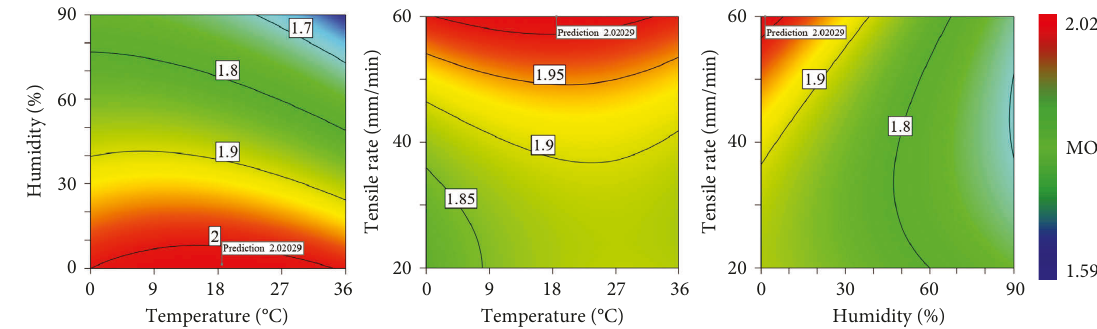
Figure 6: Response surface prediction point location map. Table 4: Prediction error and